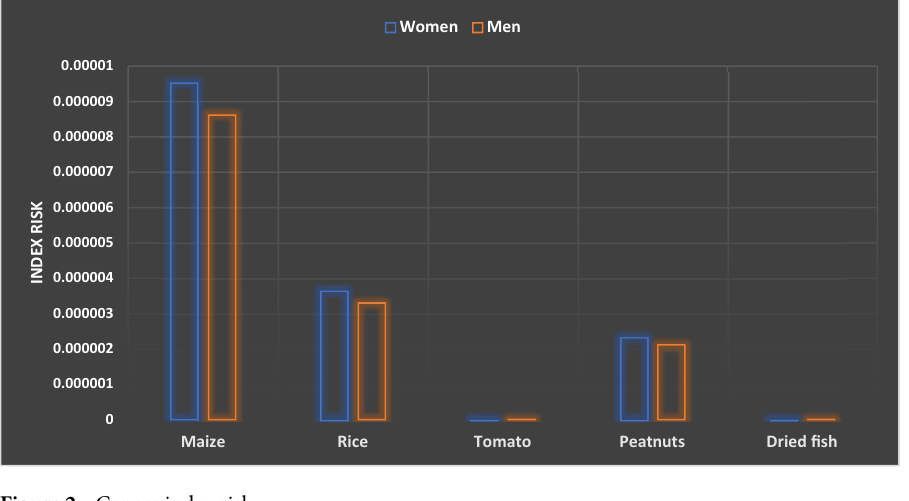
Figure 2. Cancer index